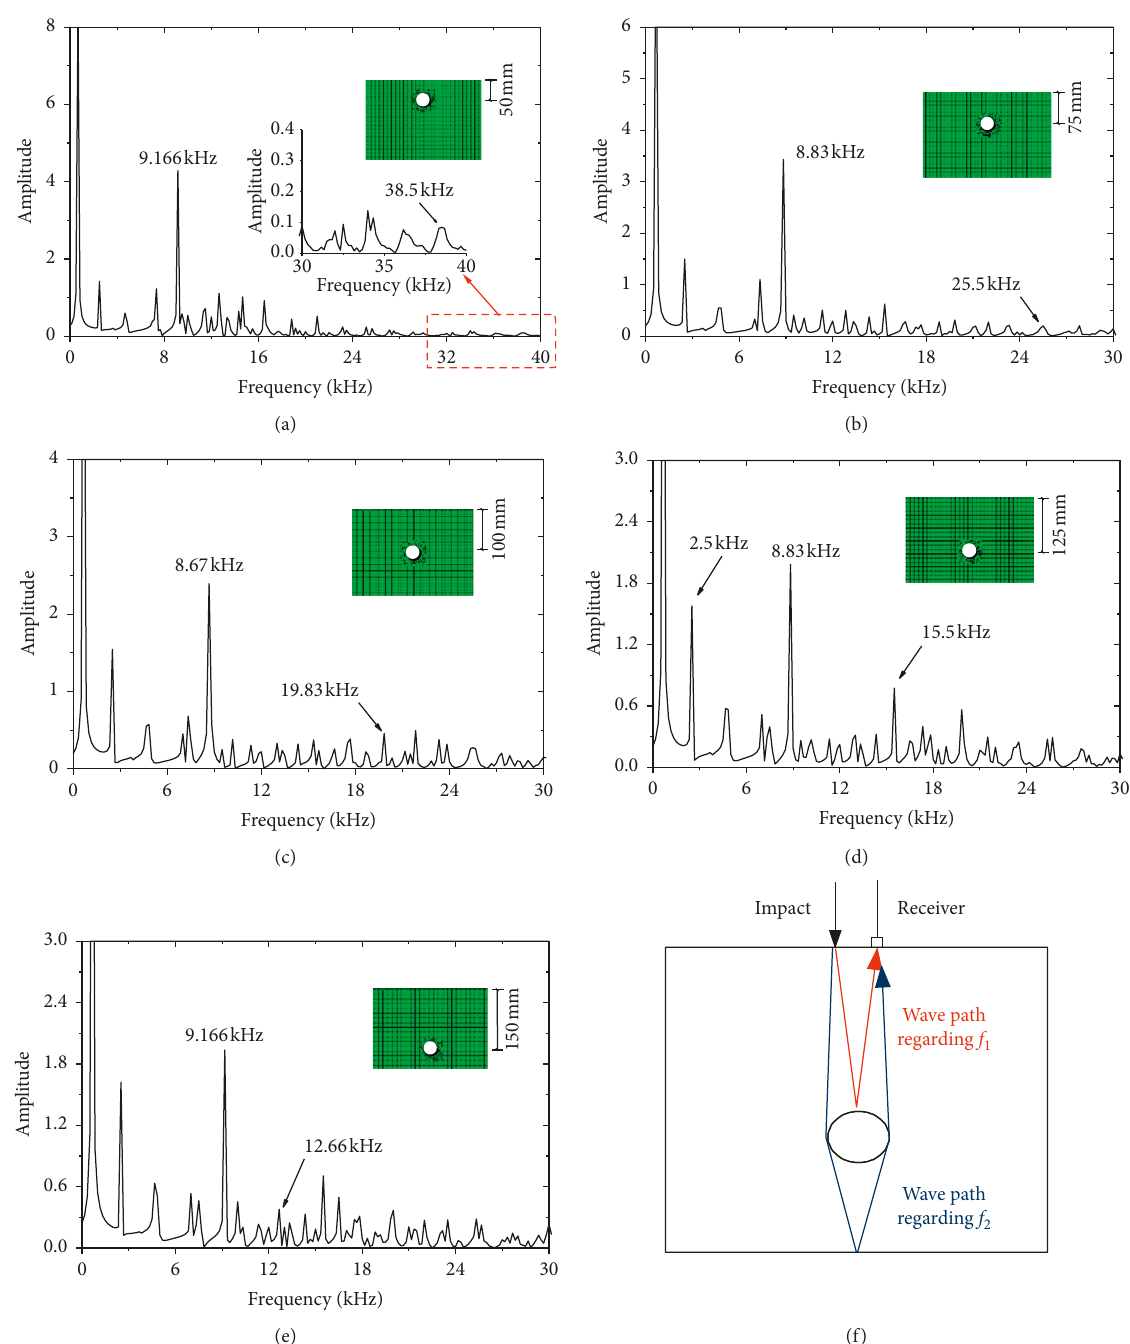
Figure 12: Corresponding frequencies of different depths of hole. (a) 50 mm. (b) 75mm. (c) 100mm. (d) 125mm. (e) 150 mm. (f) Wave